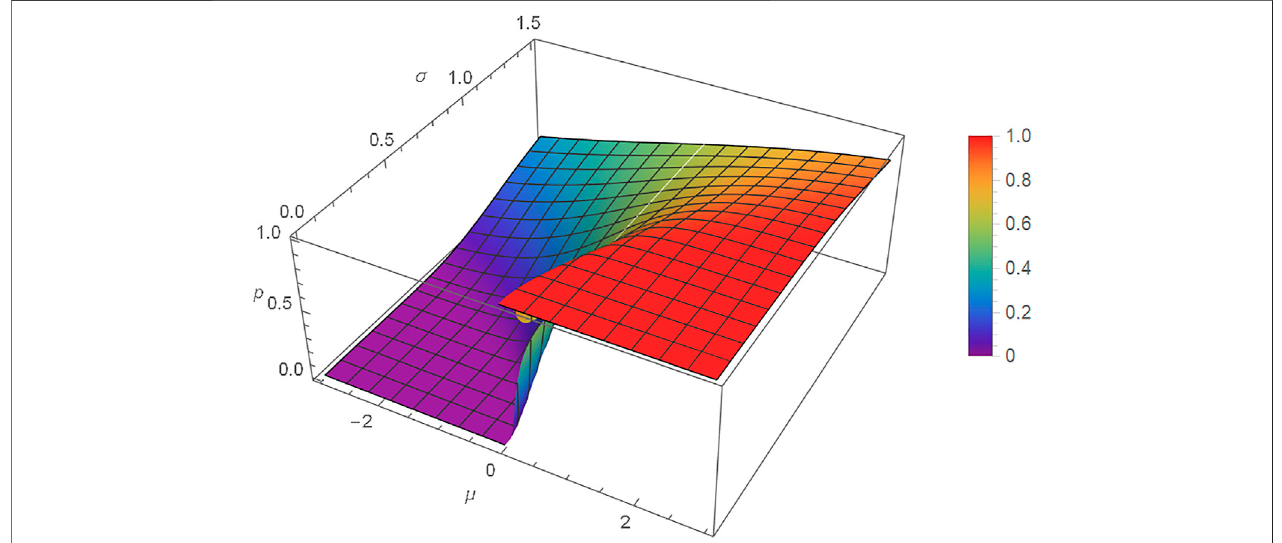
FIGURE10| Plotof P .6 ( z (cid:2) 1 ) for μ ∈ ( − 3,3), σ ∈ (0,1.5).Thelimited rangeisduetothefactthattheplotisextremelycloseto1forlarge μ andsmall σ .Thefunction is continuous and is equal to 0.6 when μ =